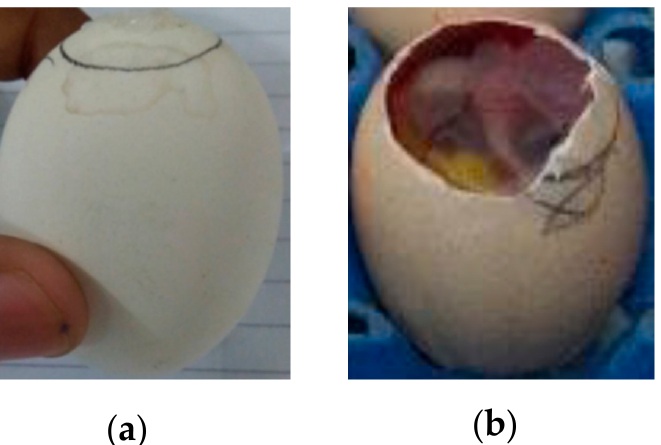
Figure 2. ( a ) The virus and the nanoparticles inoculation; ( b ) The harvesting of Allantoic fluid. The chorioallantoic fluid (CAF) harvested from the Embryonated chicken eggs as a